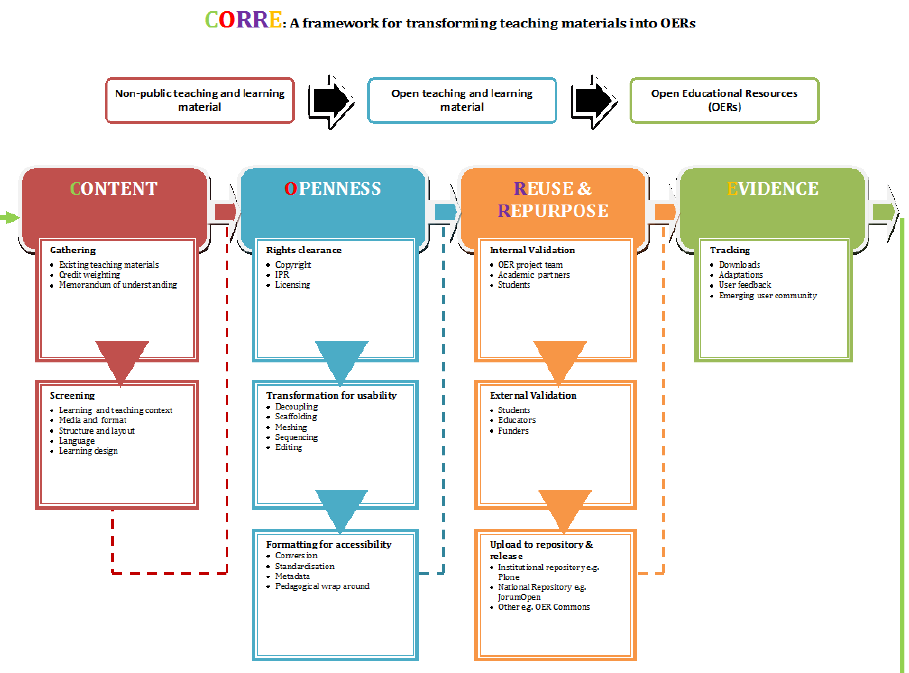
Figure 7 . The dScribe workflow (after Fons et al., 2010).